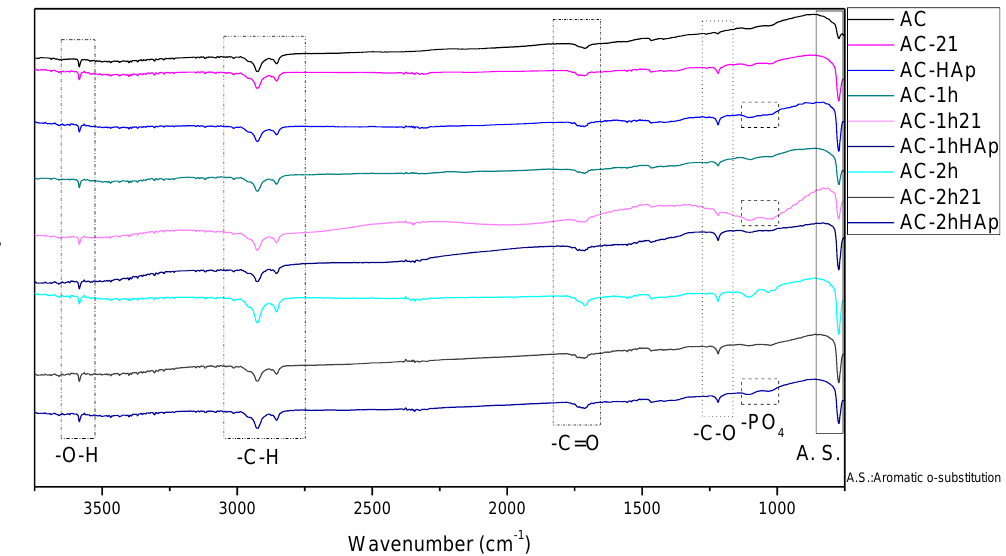
Figure 2. IR spectra of the carbon samples with different modifications.